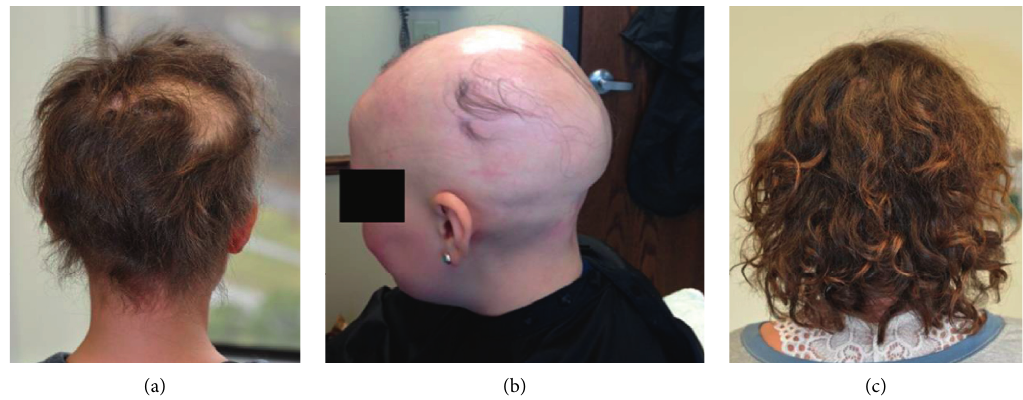
Figure 2: Progression of alopecia: early stages of disease (a), progression of disease (b), improvement in alopecia (c).